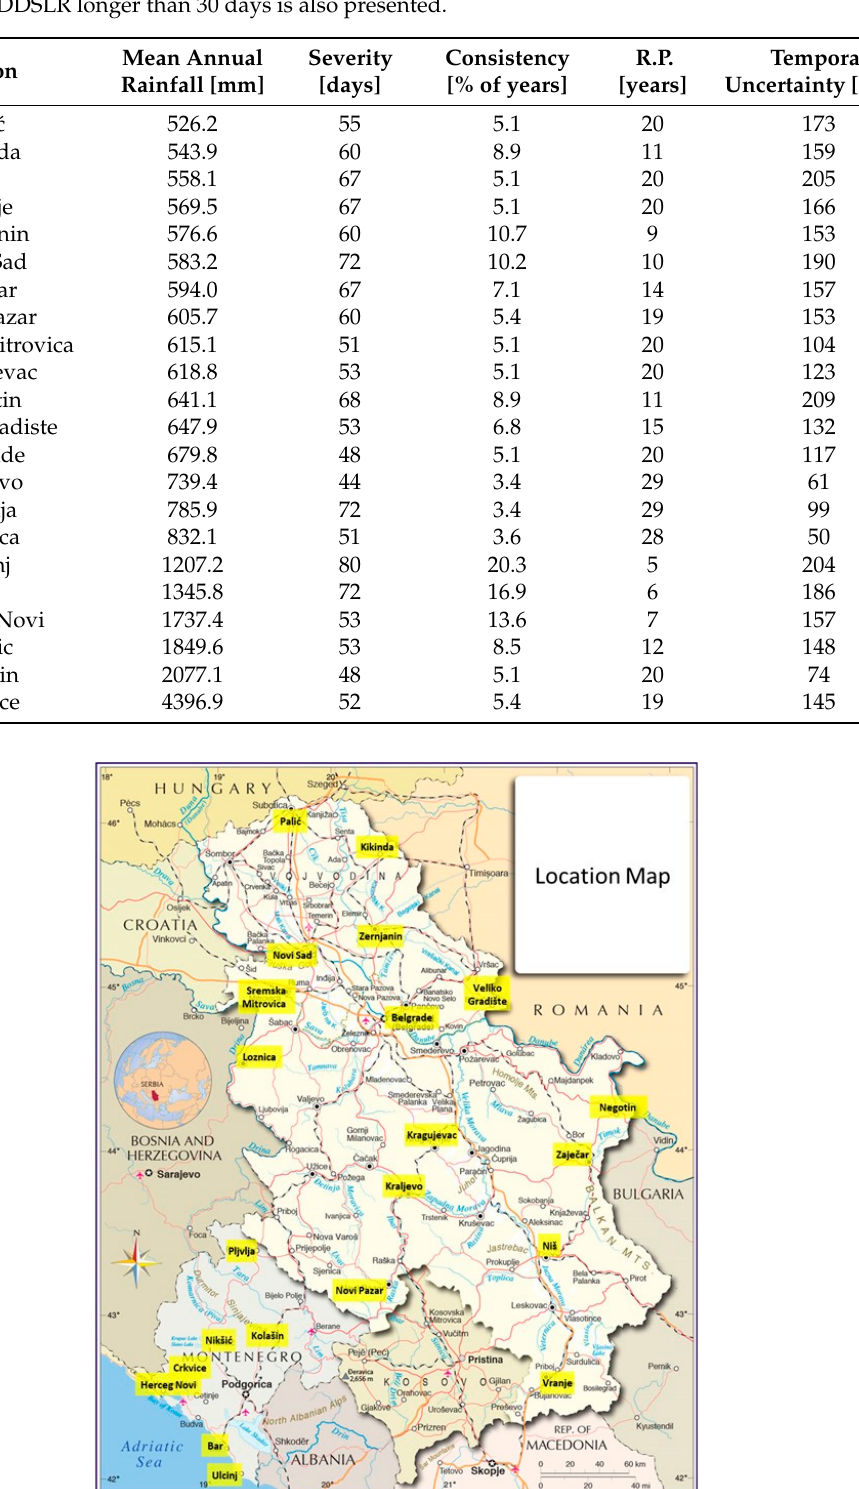
Table 1. Three metrics of the DDSLR in selected stations in Serbia and Montenegro. Stations are arranged in an ascending order of their mean annual rainfall. The severity represents the longest DDSLR, the consistency, the percentage of years with DDSLR longer than 30 days and the temporal uncertainty, the span of days along the year when such an event may be expected. The return period (R.P.) of a DDSLR longer than 30 days is also presented.